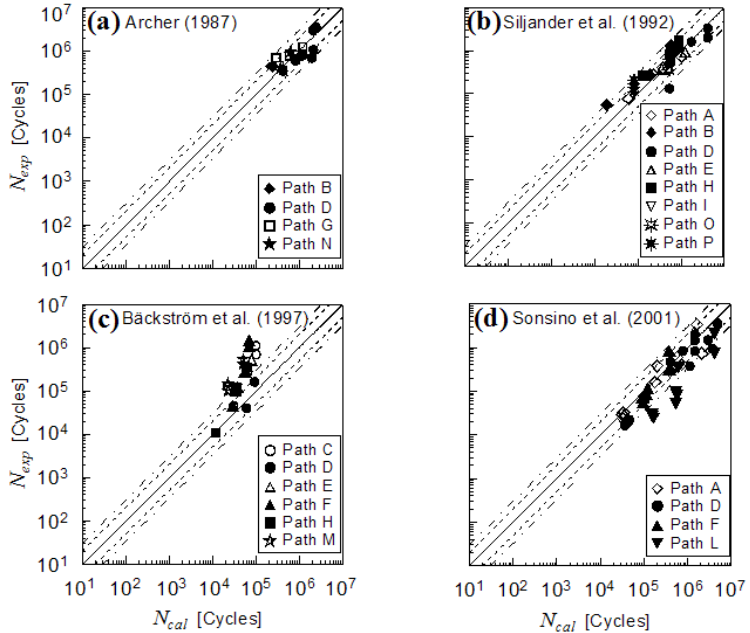
Figure 4: Experimental fatigue life exp N vs predicted fatigue life cal N for each experimental data set analysed [11, 19–21].